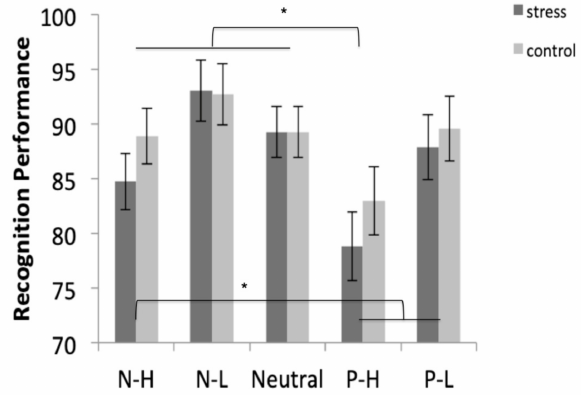
Figure 5. Recognition performance for negative-high (N-H), negative-low (N-L), neutral, positive-high (P-H), and positive-low (P-L) pictures in stress and control conditions. Error bars represent standard error of mean (S.E.M.) (* p < 0.05).